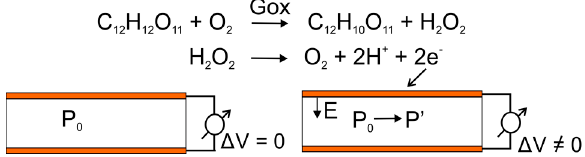
Figure 2. The schematic capacitive sensor before and after the reaction.